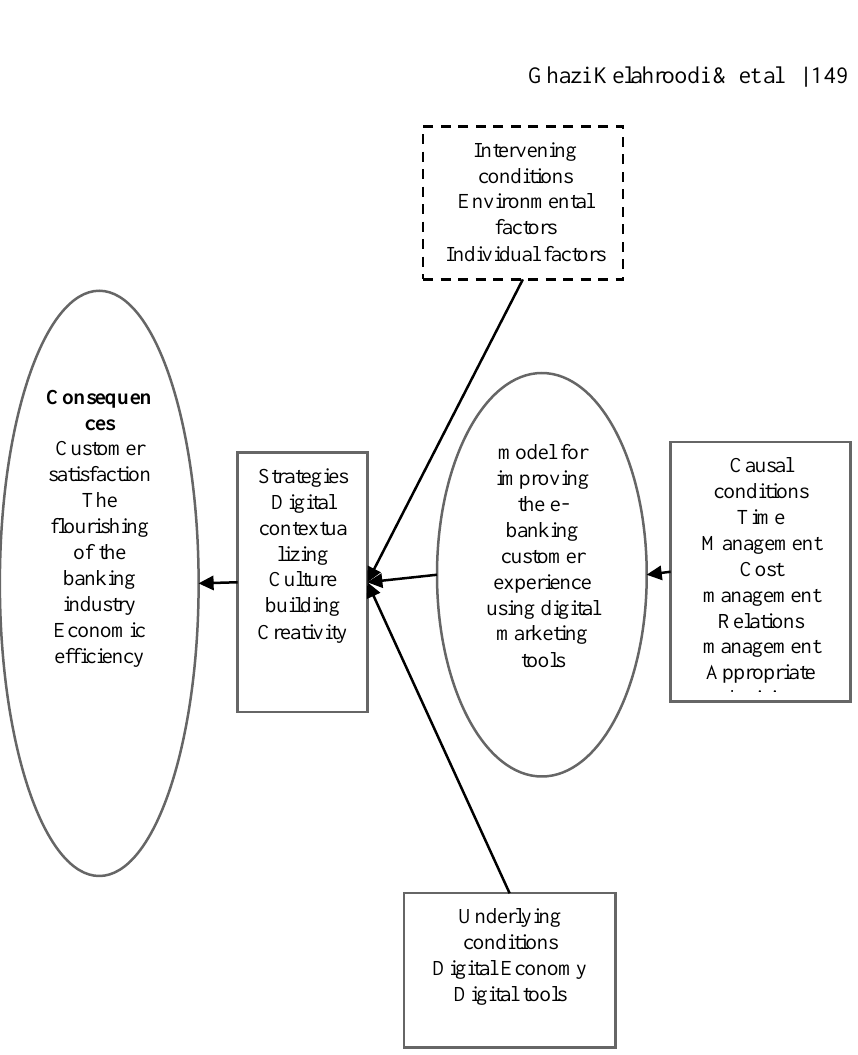
Figure 1 - Graphic output of AtlasTi